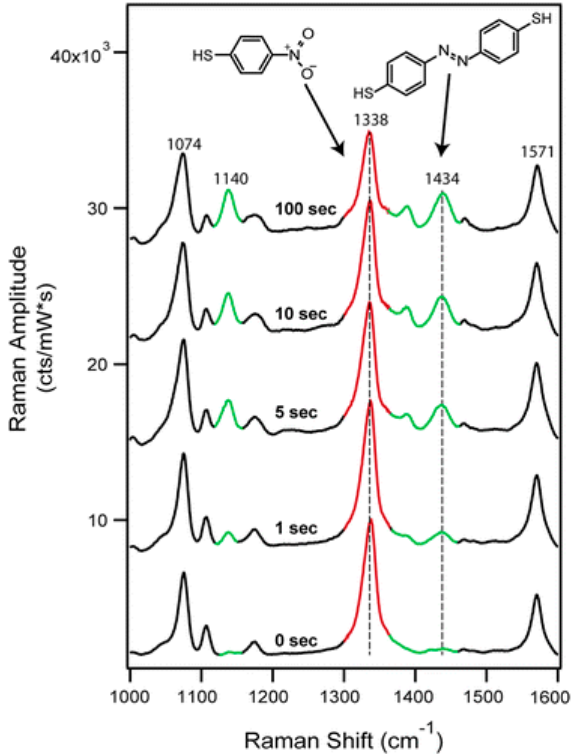
Figure 7. Time-resolved SERS measurements during the plasmon-driven conversion of 4NBT to DMAB. The reactant peak at 1338 cm − 1 decays during SERS measurement, and the product peak at 1434 cm − 1 grows during SERS measurement [45].